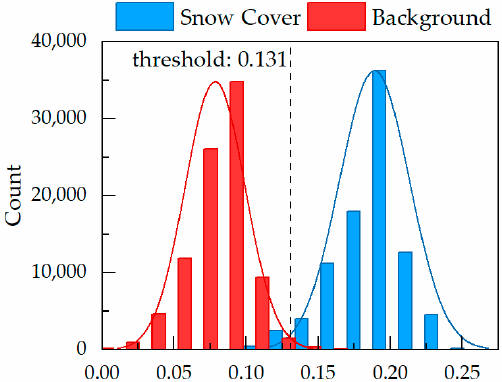
Figure 10. Histograms of the RSI values of the 90,000 snow cover and 90,000 background pixels.